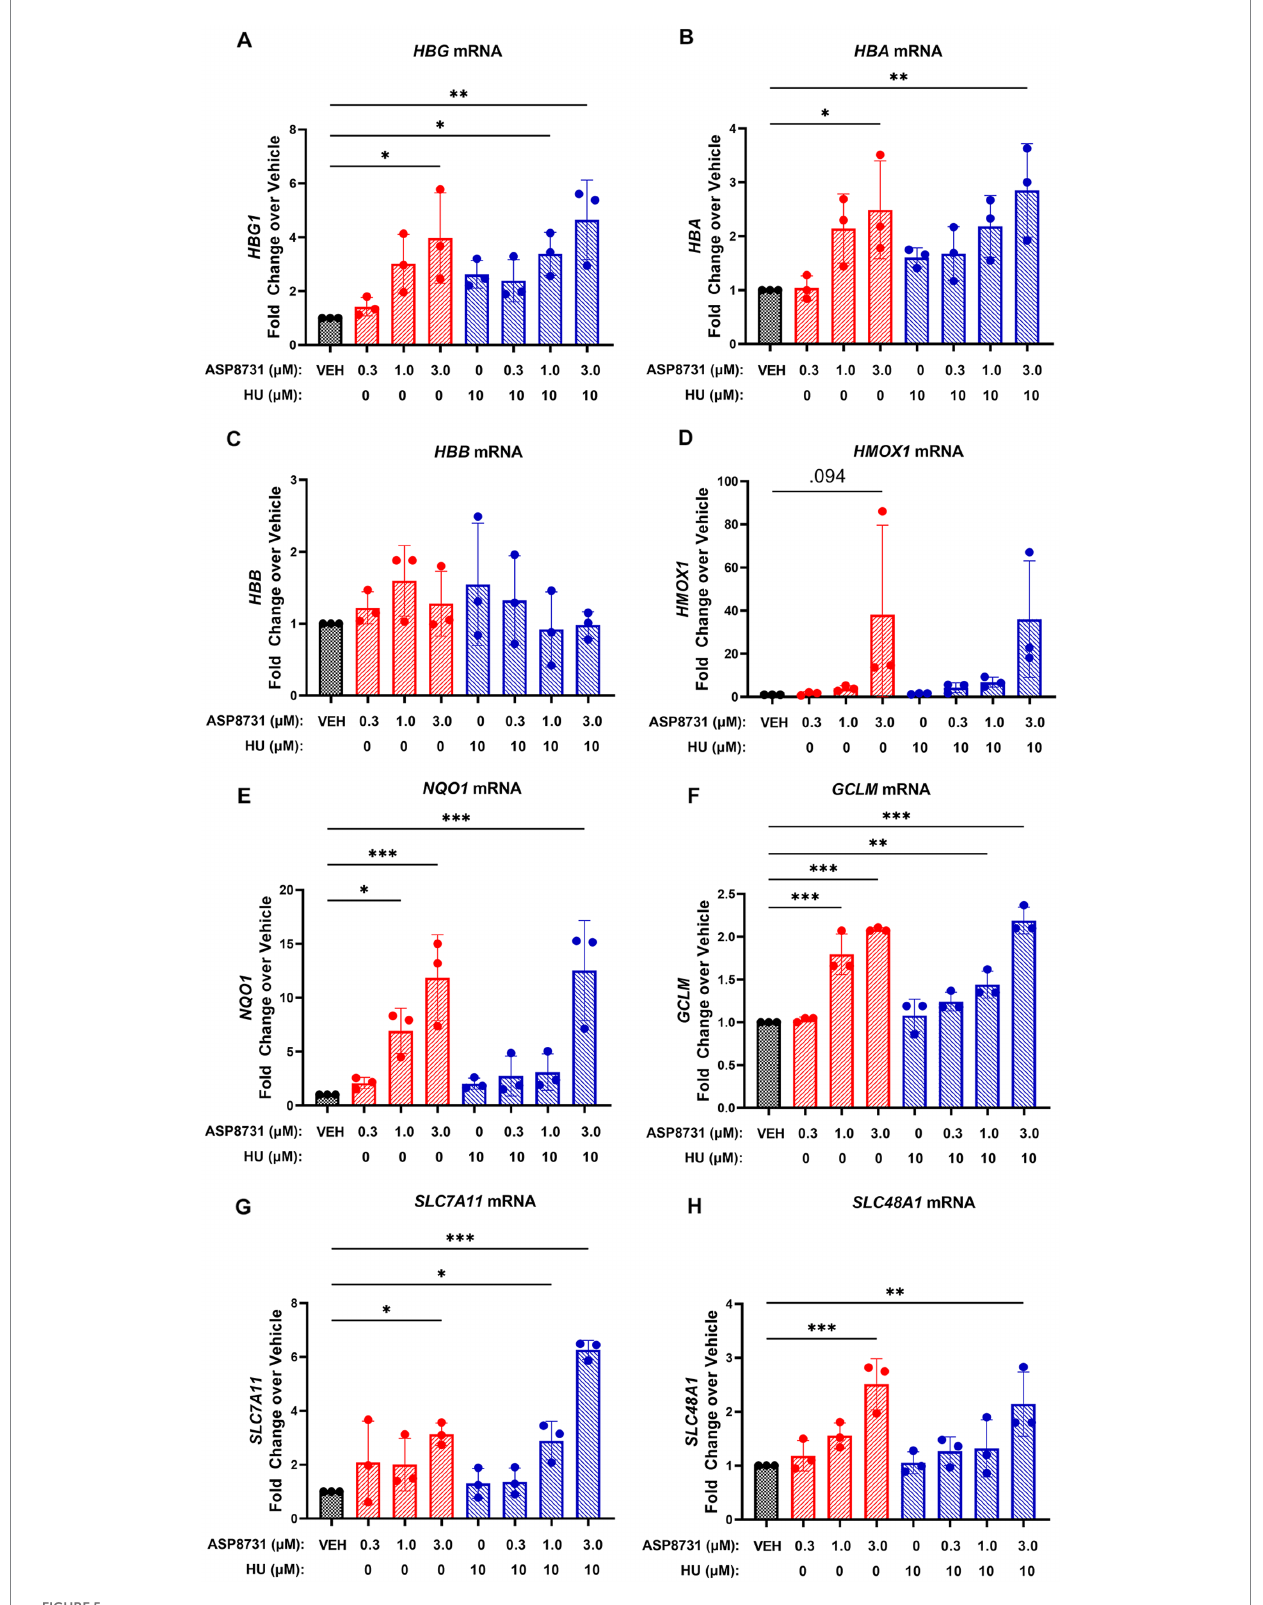
FIGURE 5 BACH1 inhibitor ASP8731 induces gamma-and alpha-globin, but not beta-globin in erythroid differentiated CD34 cells derived from SCD subjects. Peripheral blood CD34+ cells isolated from SCD subjects ( n = 3) were expanded (days 1–7) and differentiated (days 7–10) to erythroid cells in cell culture. Cells were differentiated in the presence of the indicated concentrations of ASP8731, HU, or DMSO (VEH) on days 7–10. Cells were collected